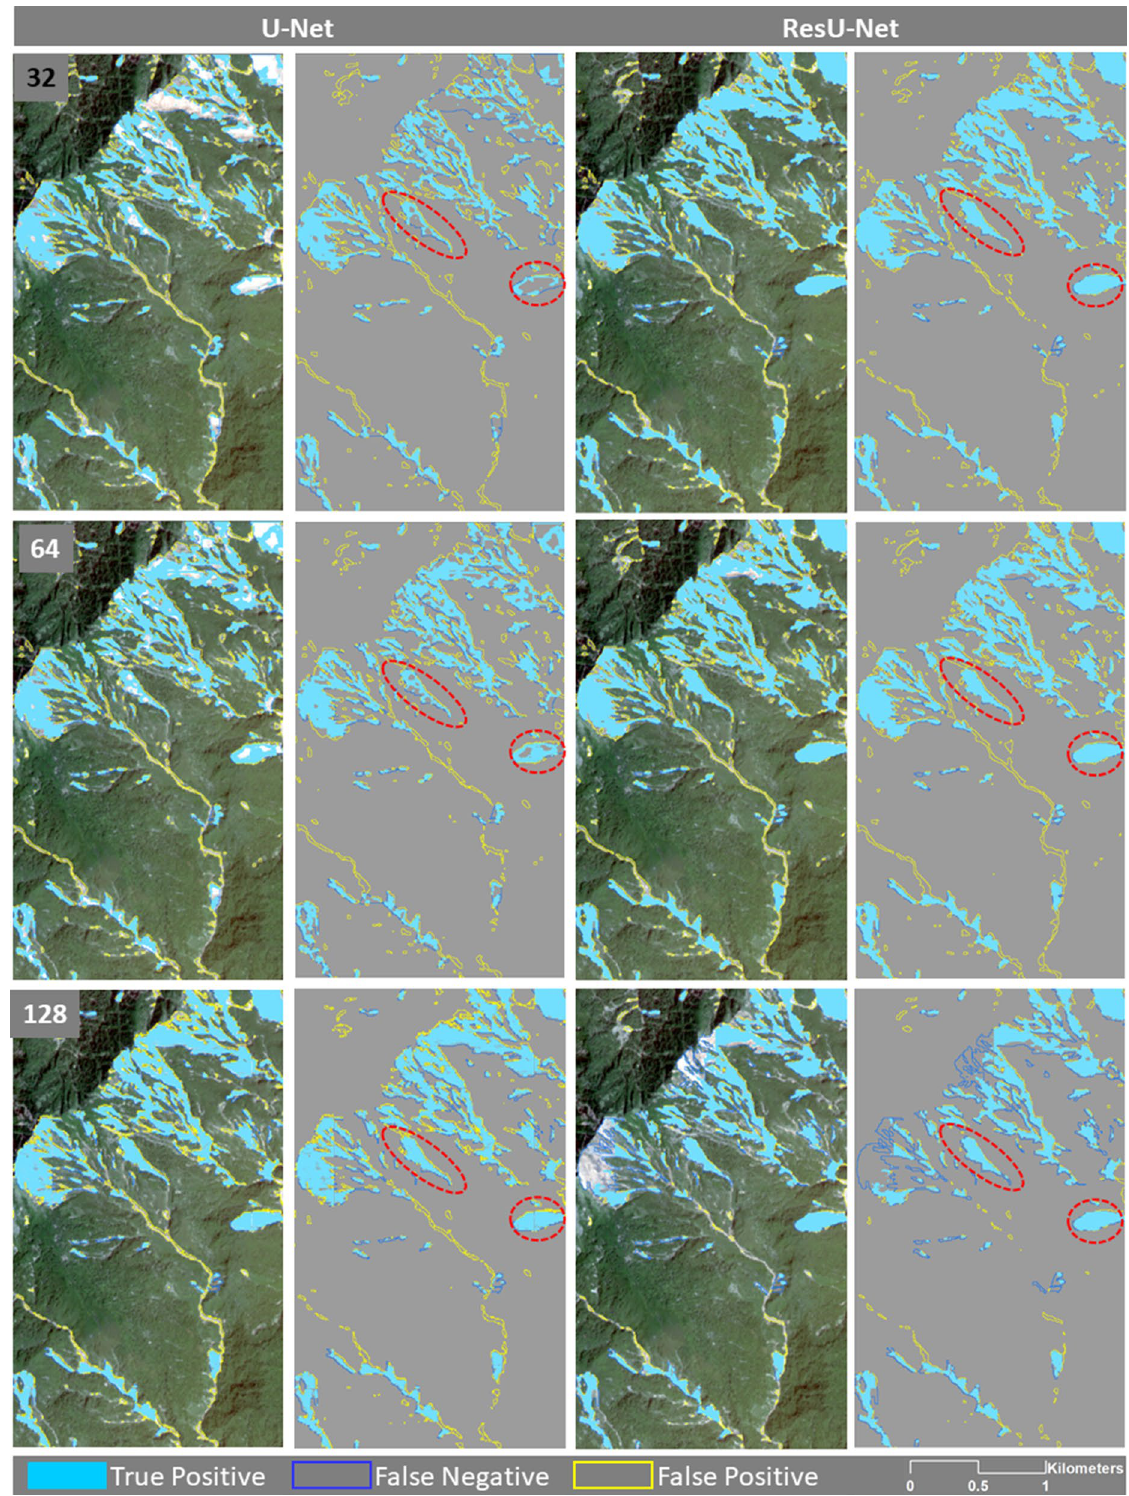
Figure 7. The enlarged areas of the results of the U-Net and ResU-Net trained and tested on Taiwan datasets using different sample patch sizes. Red ovals are showing examples of differences in the results. The maps were created using Python 3.6 (https:// www. python. org/) and the ArcMap v.10.8 software (https:// deskt op. arcgis. com/ es/